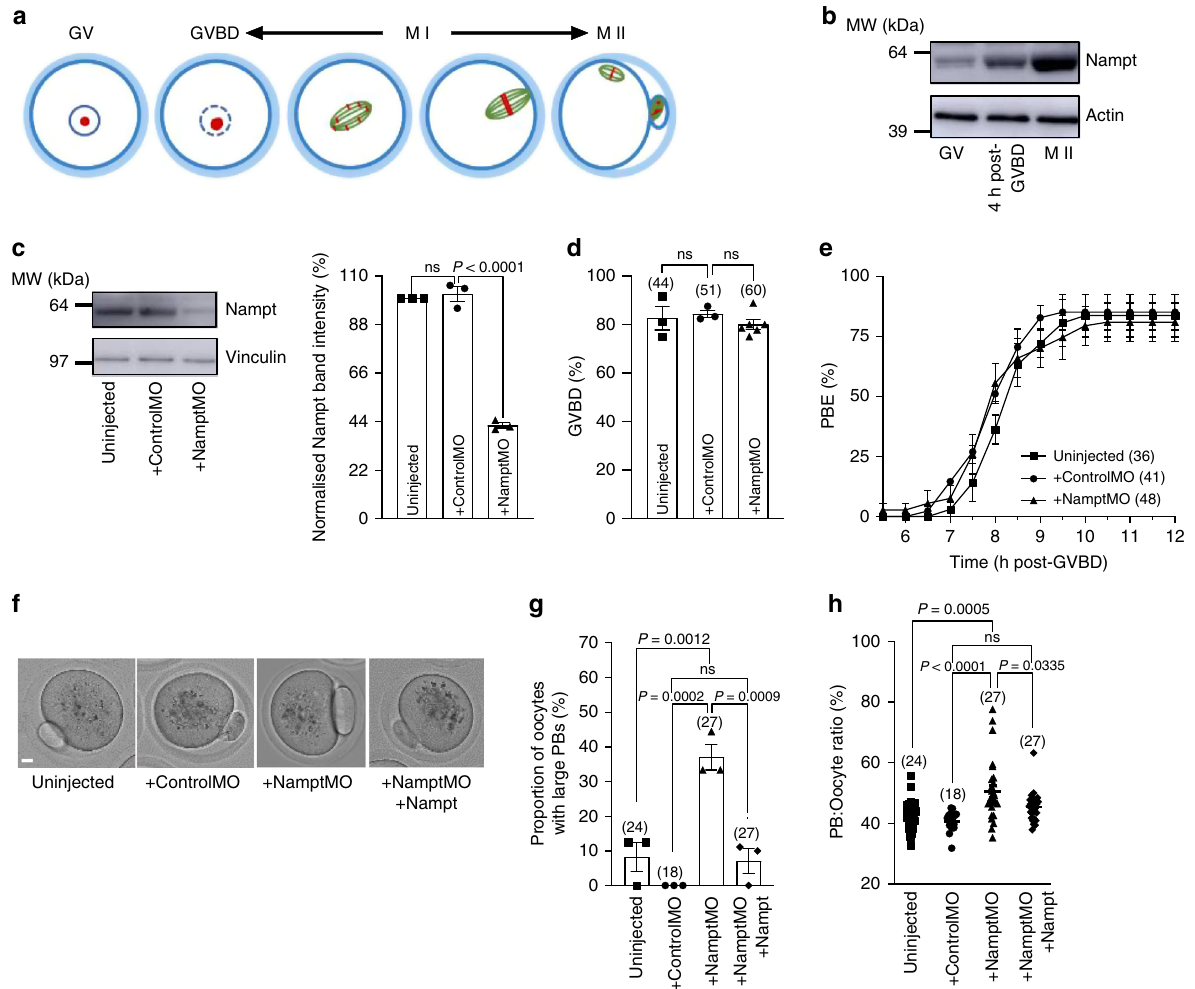
Fig. 1 Depletion of Nampt compromises asymmetry. a Schematic depicting stages of meiotic maturation and asymmetric division in oocytes. b Western blot of endogenous Nampt levels during meiotic maturation; n = 30 oocytes per lane. Representative blot from three independent experiments is shown. c Uninjected, controlMO- and NamptMO-injected oocytes were immunoblotted for Nampt. Vinculin served as a loading control (left); n = 15 oocytes per lane. Experiments were repeated three times. Quanti fi cation of Nampt protein levels (right). d , e GVBD rates 2 h following release from IBMX ( d ) and PBE rates relative to time of GVBD ( e ) in uninjected, controlMO- and NamptMO-injected oocytes. f Bright fi eld images of representative uninjected, mock- depleted and Nampt-depleted oocytes as well as Nampt-depleted oocytes co-injected with recombinant Nampt. Scale bar, 10 μ m. Representative images from three independent experiments are shown. g Proportion of oocytes with large PBs. See Methods for further details. h Ratio of PB width to oocyte diameter. Oocyte numbers are shown in parenthesis from three independent experiments ( d , e , g , h ). Data in graphs are presented as the mean ± SEM. Data points are shown in c , d and g . P- values are shown in the graphs, ns denoted P > 0.05. Statistical comparisons were made using one-way ANOVA in c , d , g and h . See also Supplementary Movie 1. Source data are provided as a Source Data fi